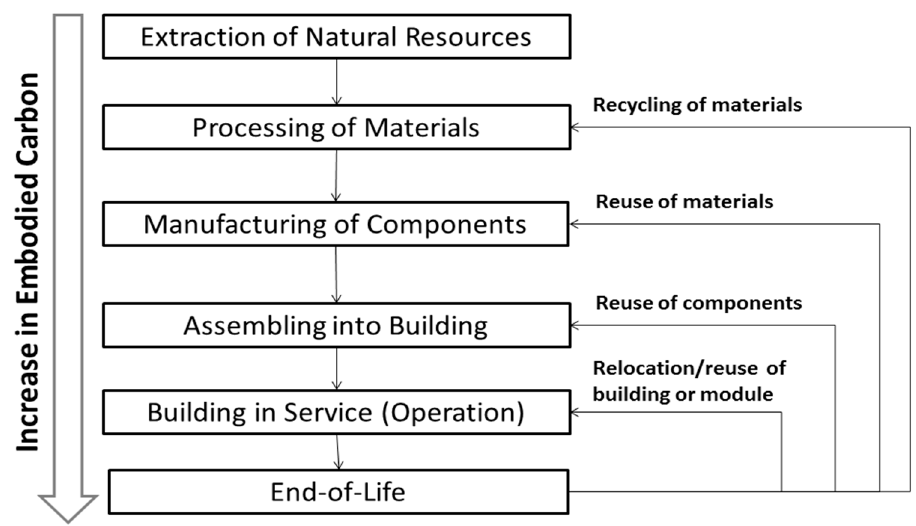
Figure 2. Increase in embodied carbon of a structure as it moves through different stages of its life cycle; and capability of different end ‐ of ‐ life strategies in preserving the invested embodied carbon.